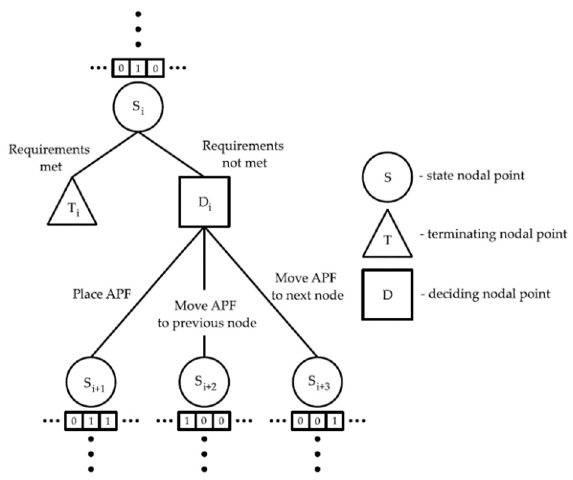
Figure 3. Schematic of recurring part of decision tree used for the optimization of active power filter (APF) placement [16].